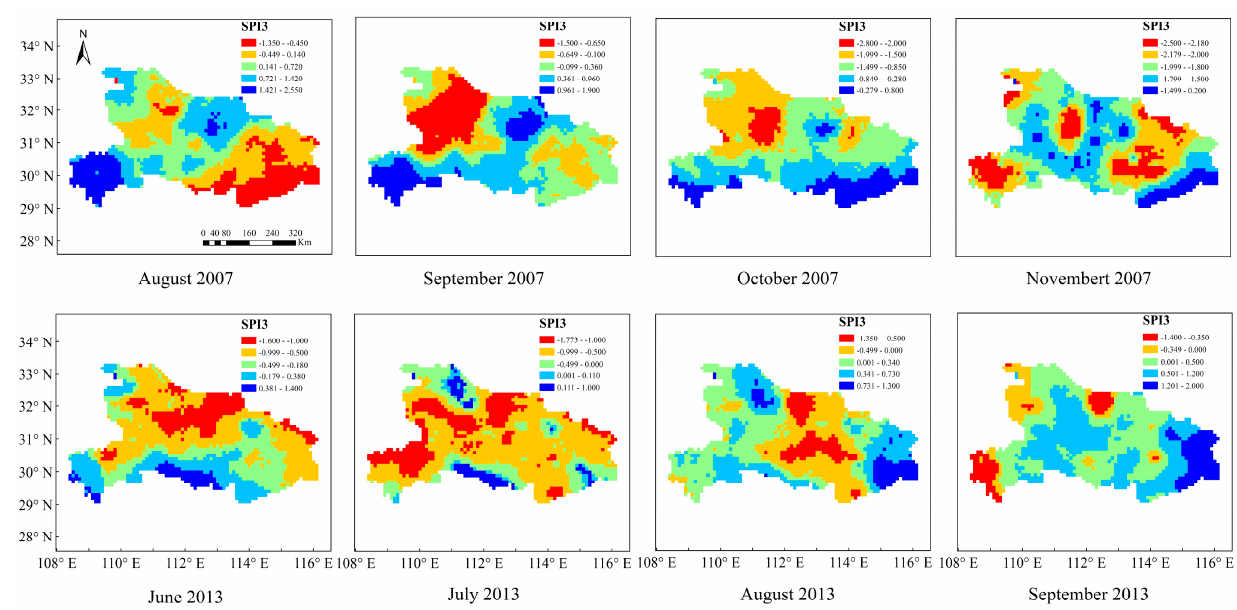
Figure 3. SPI-3 values based on the fused data in August, September, October, and November 2007 and June, July, August, and September 2013.